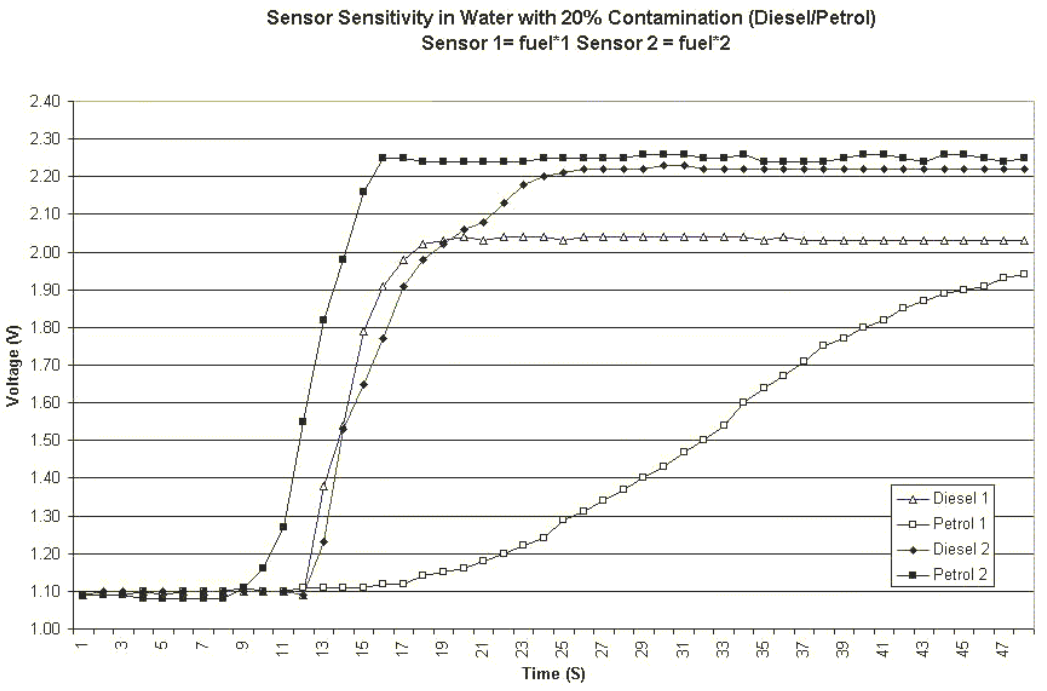
FIGURE 4. Sensor response to 20% free-phase fuels in